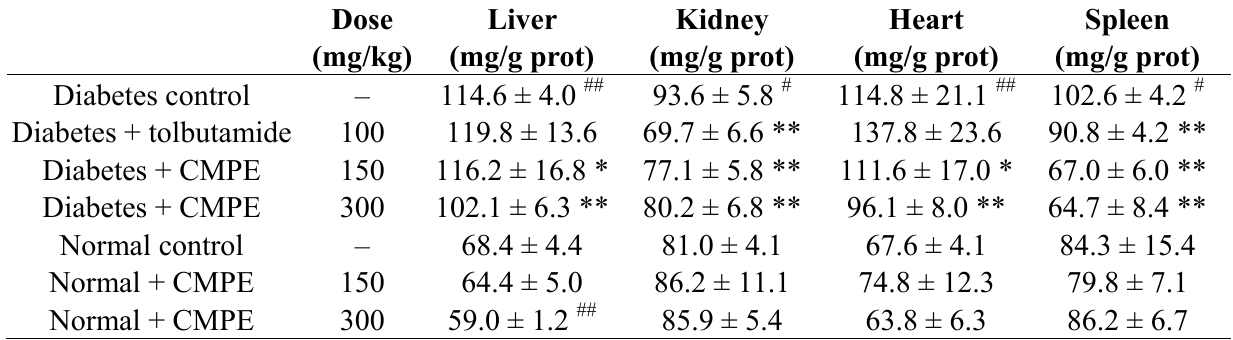
Table 4. Effects of CMPE on GSH levels in tissues of normal and STZ induced diabetic